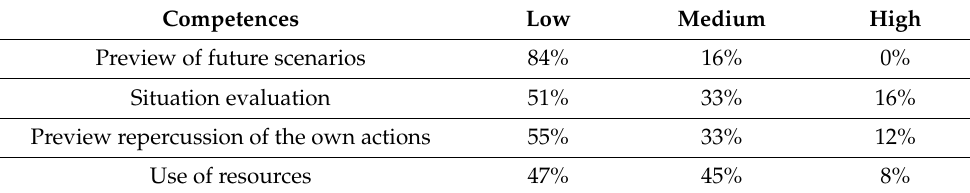
Table 4. General trend of competences among the